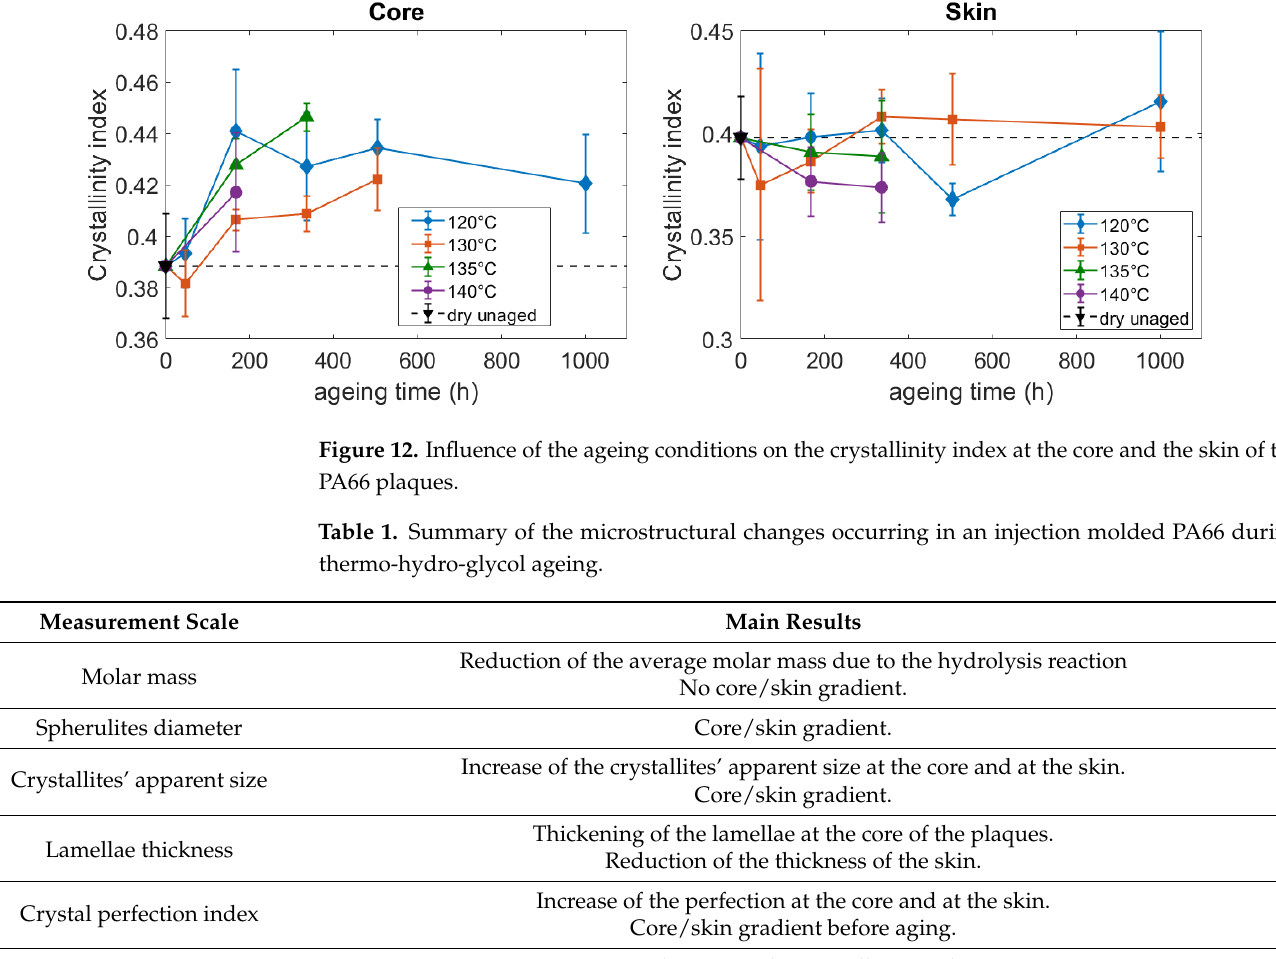
Table 1. Summary of the microstructural changes occurring in an injection molded PA66 during thermo-hydro-glycol ageing.